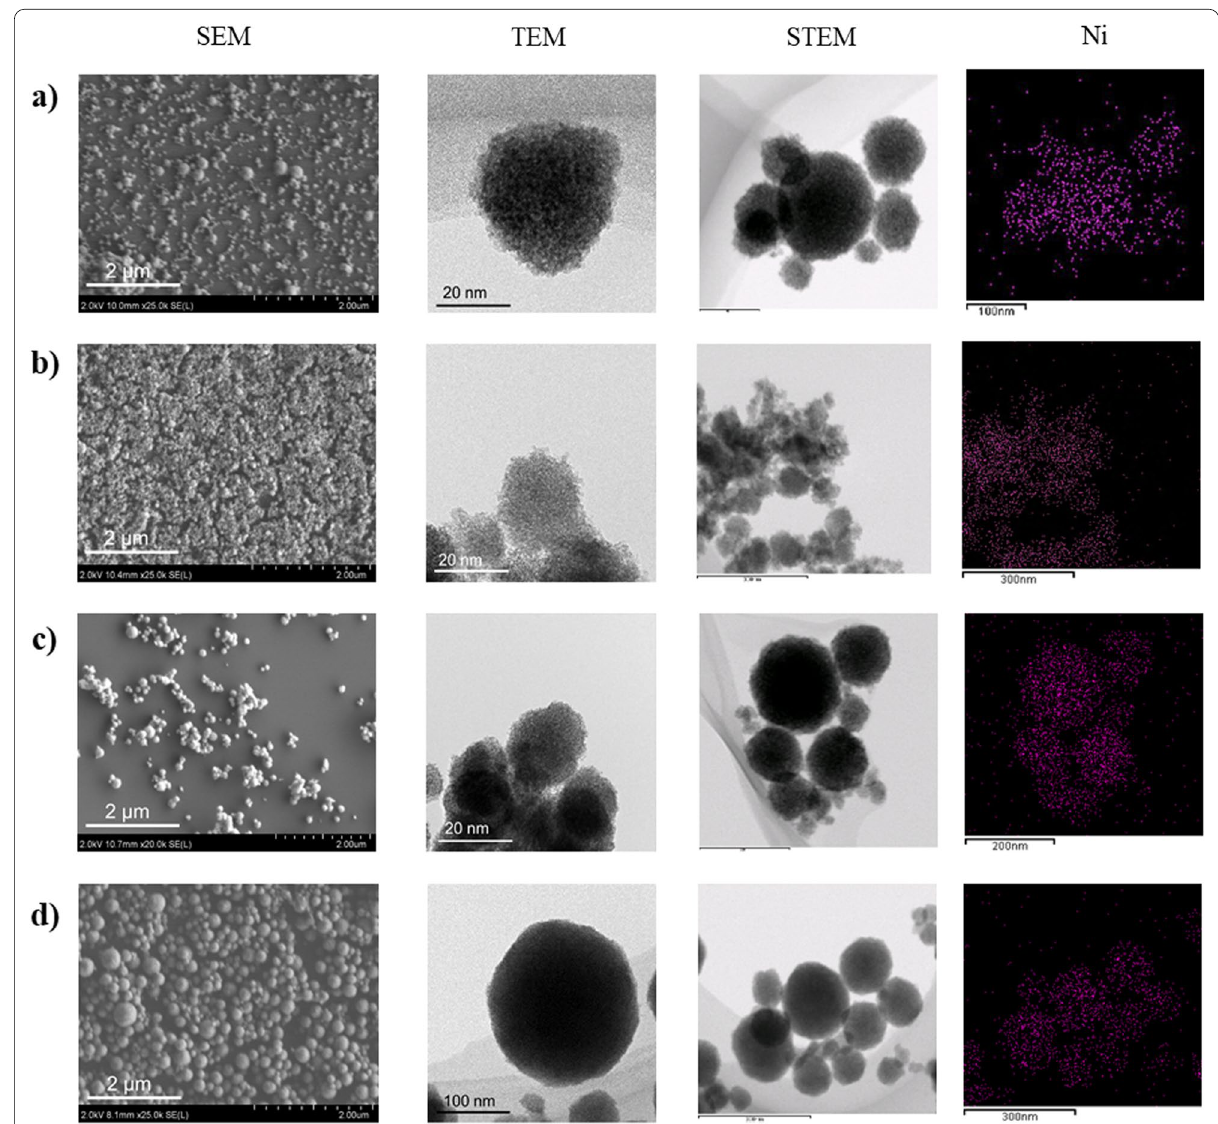
Fig. 3 SEM, TEM, and STEM/EDX images of as-prepared Ni catalysts embedded in small ZrO 2 -based supports and TEM images of them after hydrogen reduction: a S